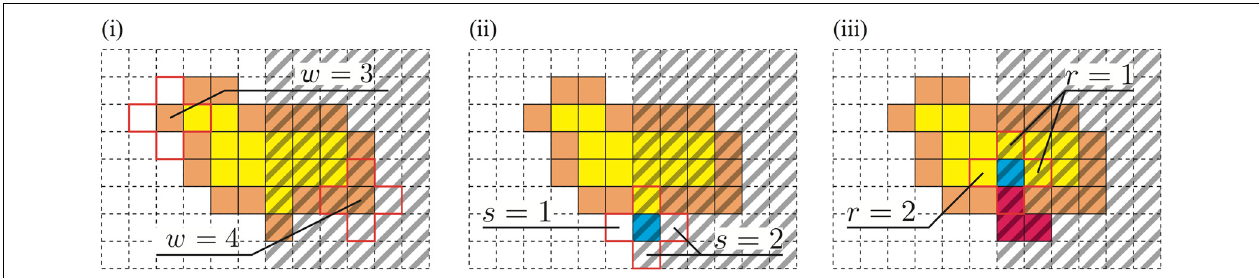
FIGURE 2 | The right part of each figure is dark, and the other area is bright. (i) The membrane at the dark site is chosen more frequently. (ii) Growth is attracted to the dark site. (iii) Avoidance of the bright